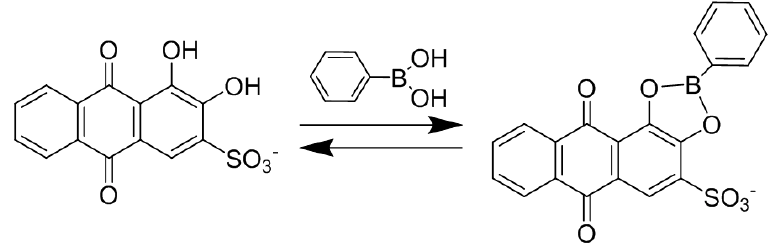
Figure 5. A binding equilibrium of ARS and PBA.